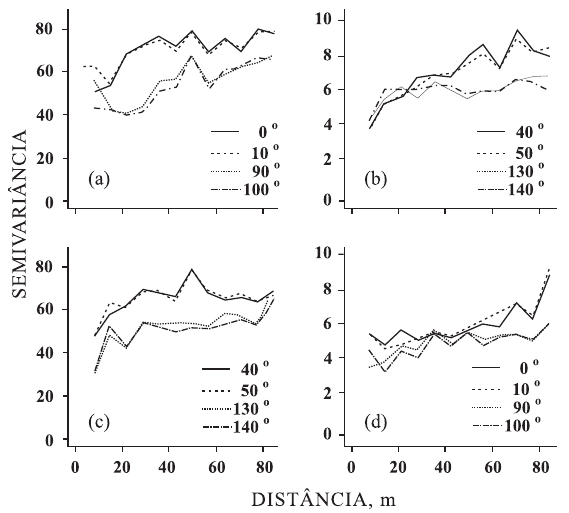
Figura 4. Semivariogramas direcionais das variáveis Fe (a), MO (b), Mn (c) e H + Al (d).